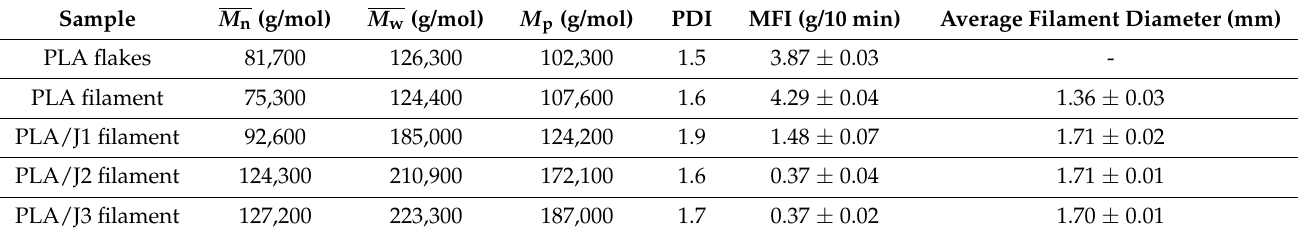
Table 1. Molecular weight, PDI (GPC), and MFI of neat PLA and PLA/J and the average filament diameter. Sample M n